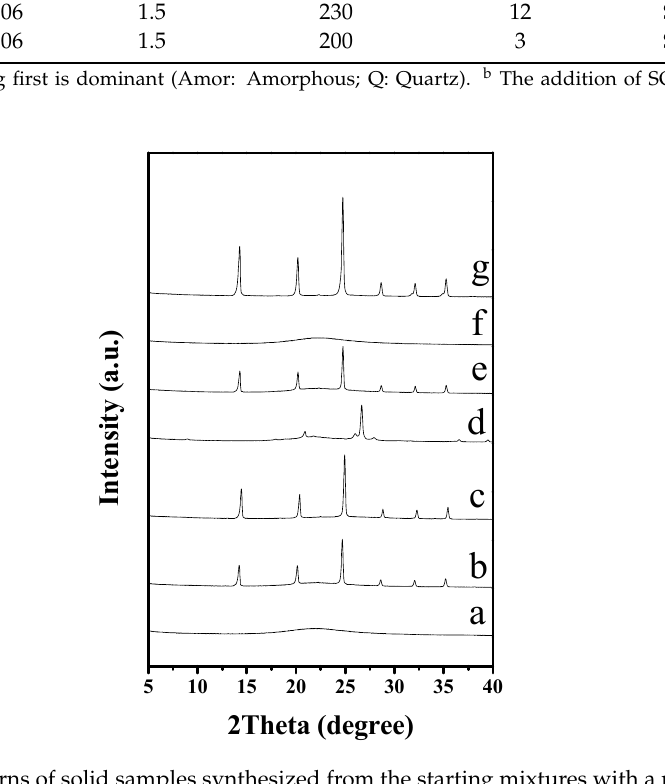
Figure 5. XRD patterns of solid samples synthesized from the starting mixtures with a molar ratio of 1.0 SiO 2 /0.01–0.11 Na 2 O/0–1.5 ethylene glycol (EG) at 160–230 °C. Na 2 O/SiO 2 ratios of ( a ) 0.01, ( b ) 0.04, and ( c ) 0.11; EG/SiO 2 ratios of ( d ) 0, and ( e ) 1.0; ( f ) 160 °C for 24 h; ( g ) 230 °C for 12 h.